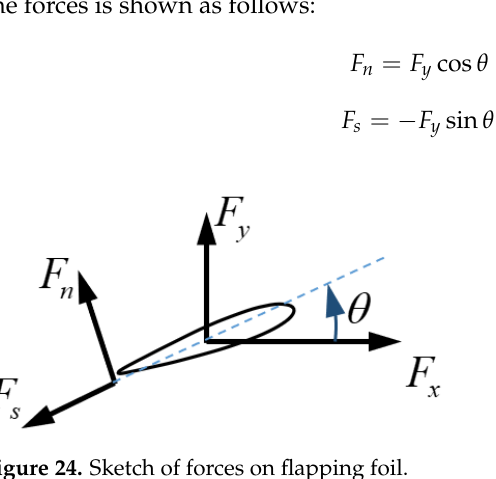
Figure 24. Sketch of forces on flapping foil.